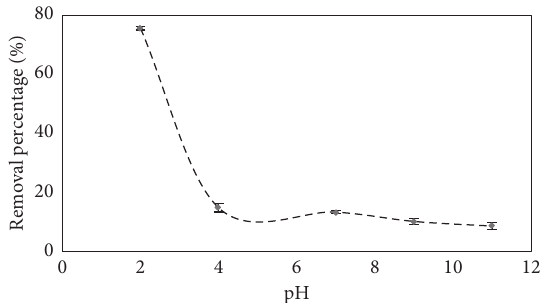
Figure 6: Effect of pH on the adsorption of Cr(VI) ions from aqueous solution using WM adsorbent at T � 298 K, time- � 120min, adsorbent dose W � 2g/L, and [Cr(VI)] �